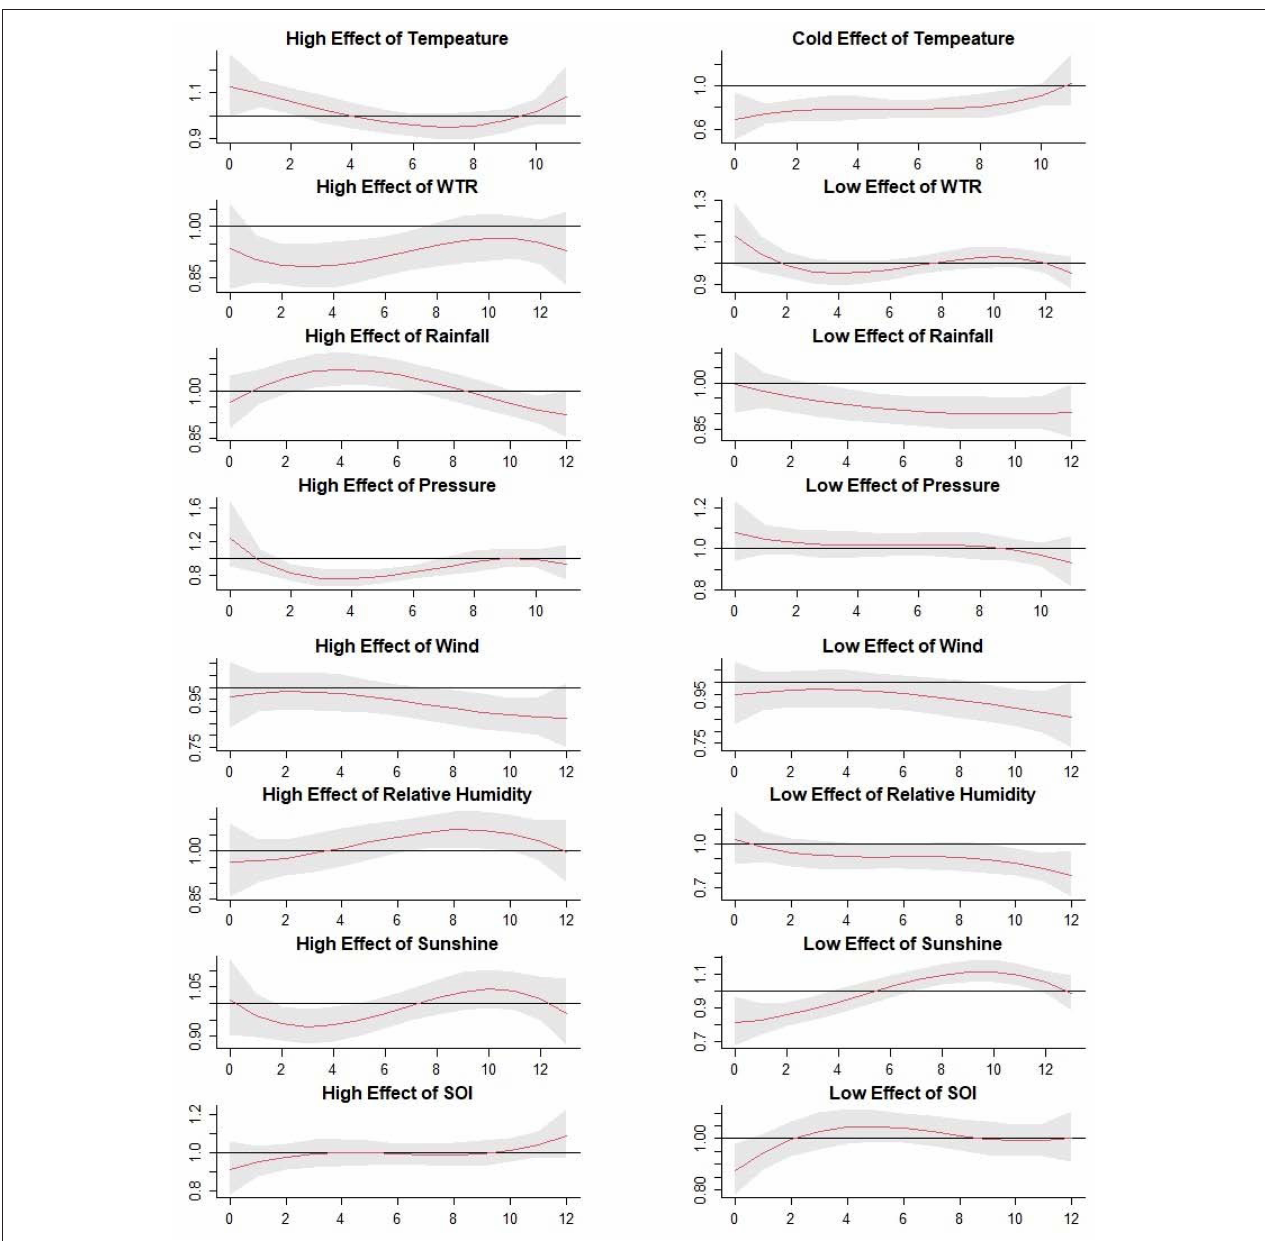
FIGURE 4 | The estimated extreme effects of mean temperature, weekly temperature range, aggregate rainfall, atmospheric pressure, wind velocity, relative humidity, hours of sunshine, and SOI with extremely high effects (97.5%) and extremely low effects (2.5%). The Y lab represents the value of relative risk, the X lab represents the value of lag weeks. The red lines represent mean relative risks and gray regions represent 95% CIs.